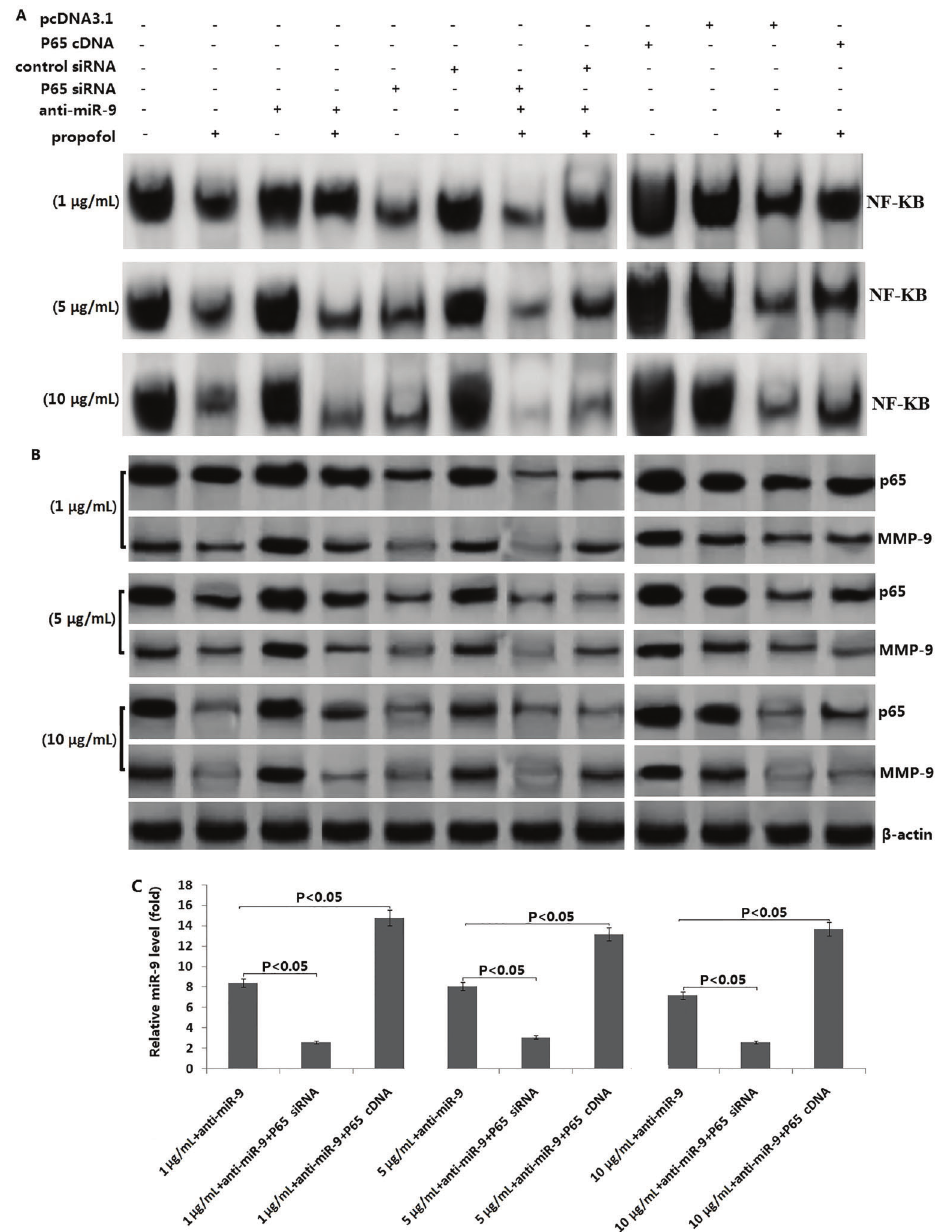
Figure 3. Effect of propofol on NF- k B -dependent MMP-9 expression. Anti-miR-9/ES-2 cells were transfected with p65 siRNA or P65 cDNA and its control for 24 h, then treated with propofol (1, 5, and 10 m g/mL) for 6 h. A , NF- k B activity was detected by EMSA in siRNA or cDNA transfected cells; B , p65 and MMP-9 protein expression was detected by western blot assay in siRNA or cDNA transfected cells; C , MMP-9 activity was detected by ELISA. The t-test was used for statistical